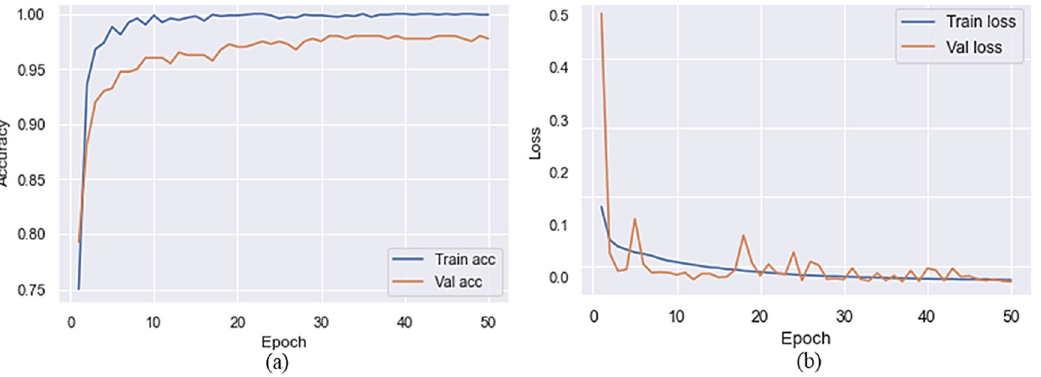
Figure 6. Training/validation accuracy and loss of the proposed model with the preprocessing ( a ) accuracy and ( b ) loss.